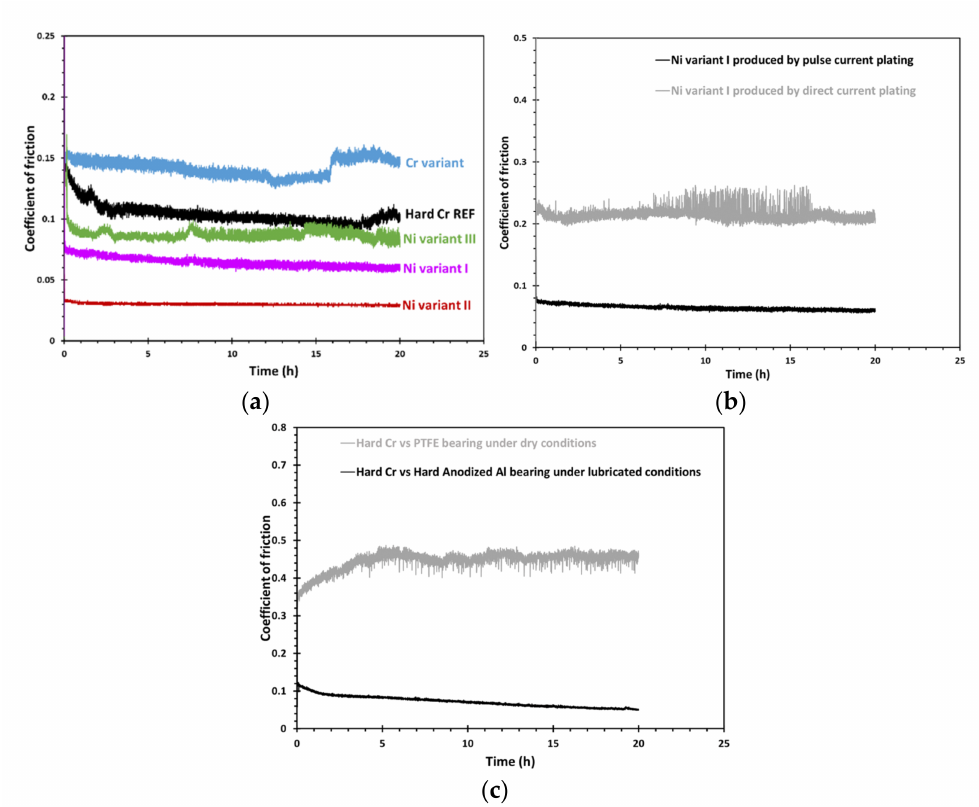
Figure 6. ( a ) Evolution of coefficient of friction of for four different optimized candidate coatings and hard Cr reference rods sliding against anodized Al rods under lubricated conditions. ( b ) Effect of plating conditions on the frictional performance of Ni variant I coated rods sliding against anodized Al rods under lubricated conditions. ( c ) Friction behavior of different rod guides vs. hard Cr reference rods.